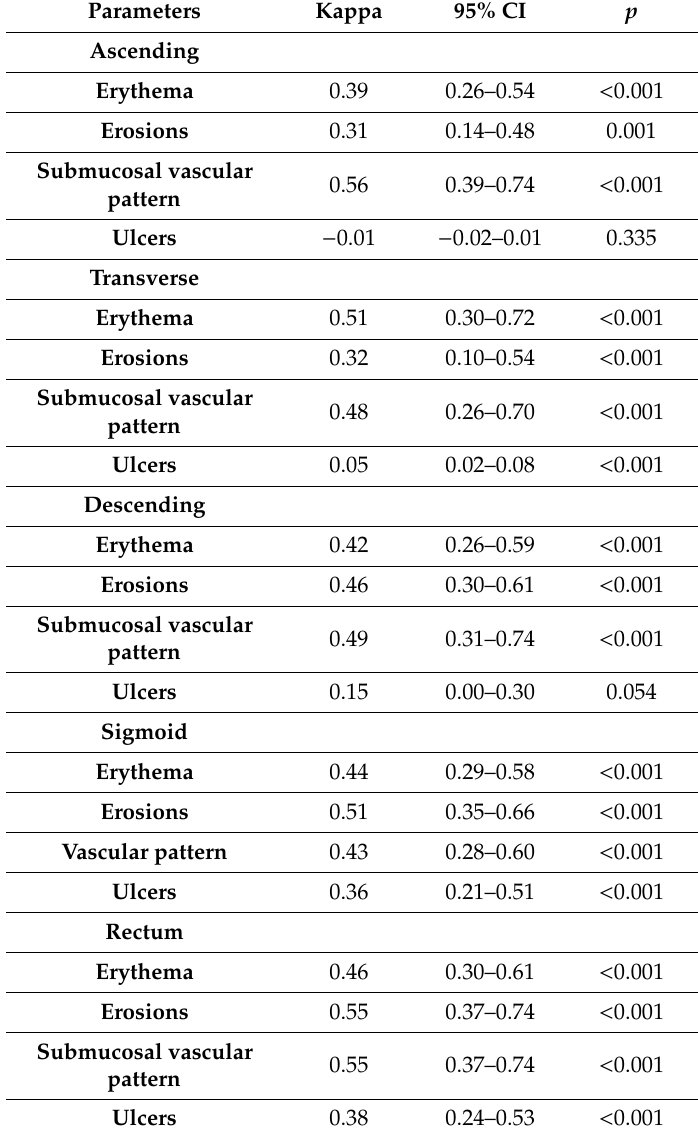
Table 1. Inter-observer agreement on EMES for each parameter of each colonic